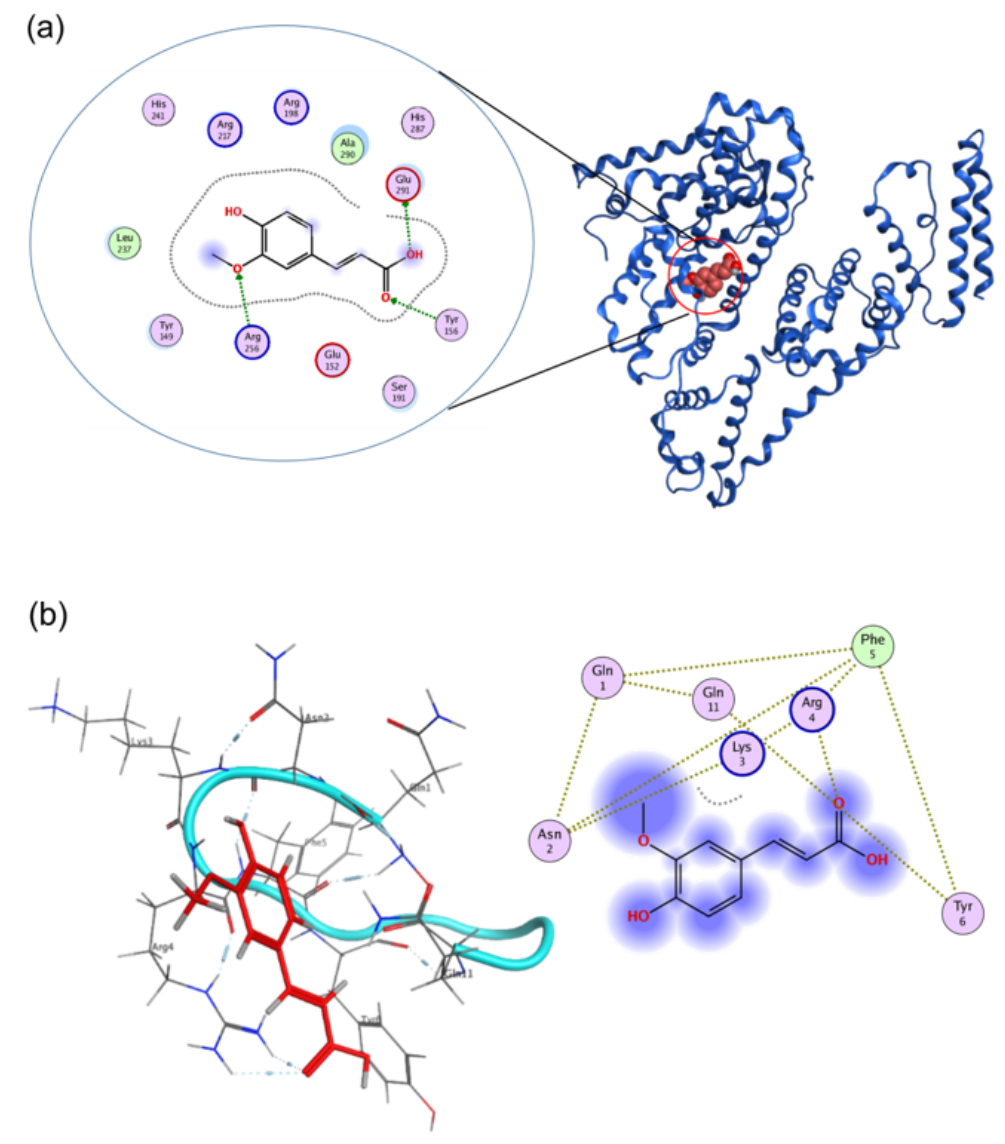
Figure 5. Molecular binding analysis using the Molecular Operating Environment. ( a ) A 3D image of FA docked onto the BSA (PDB: 3V03), and a 2D representation of the binding site and interacting residues between FA and BSA. ( b ) A 3D image of FA docked onto the CW2 and a 2D representation of the binding site and interacting residues between FA and CW2.